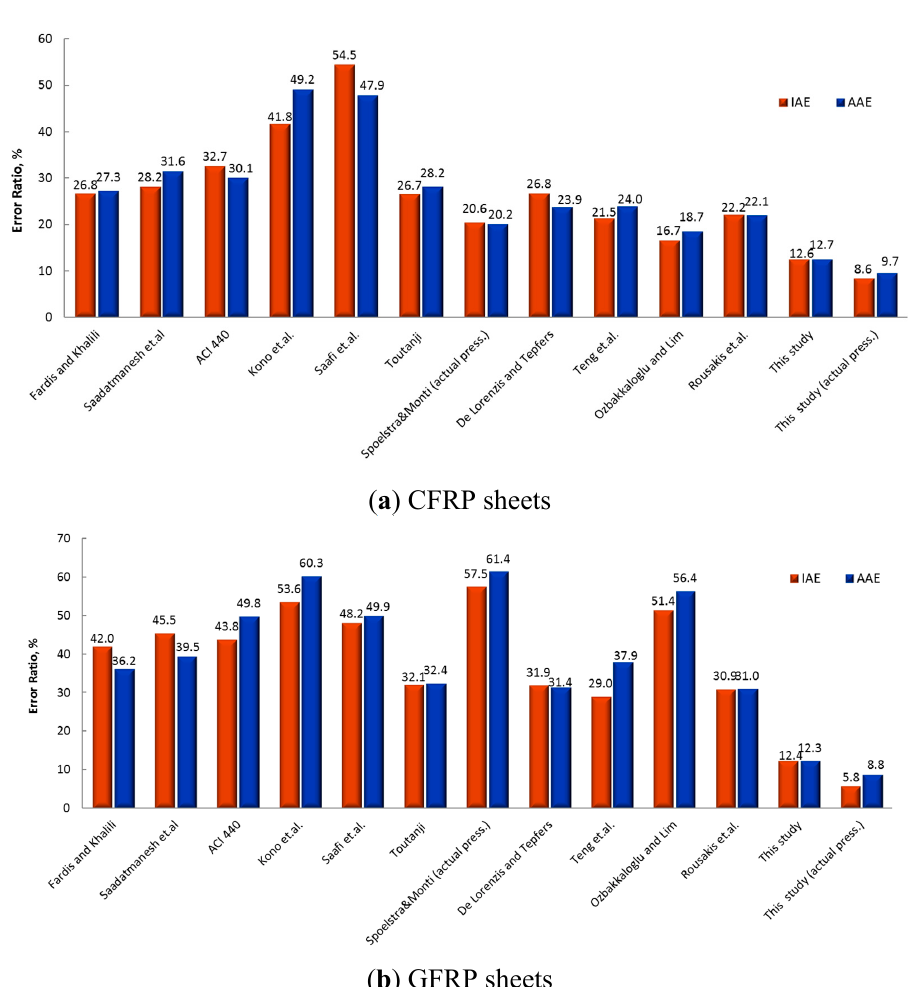
Figure 5. Error ratios of all the models under consideration for ( a ) CFRP sheets and ( b ) CFRP sheets.